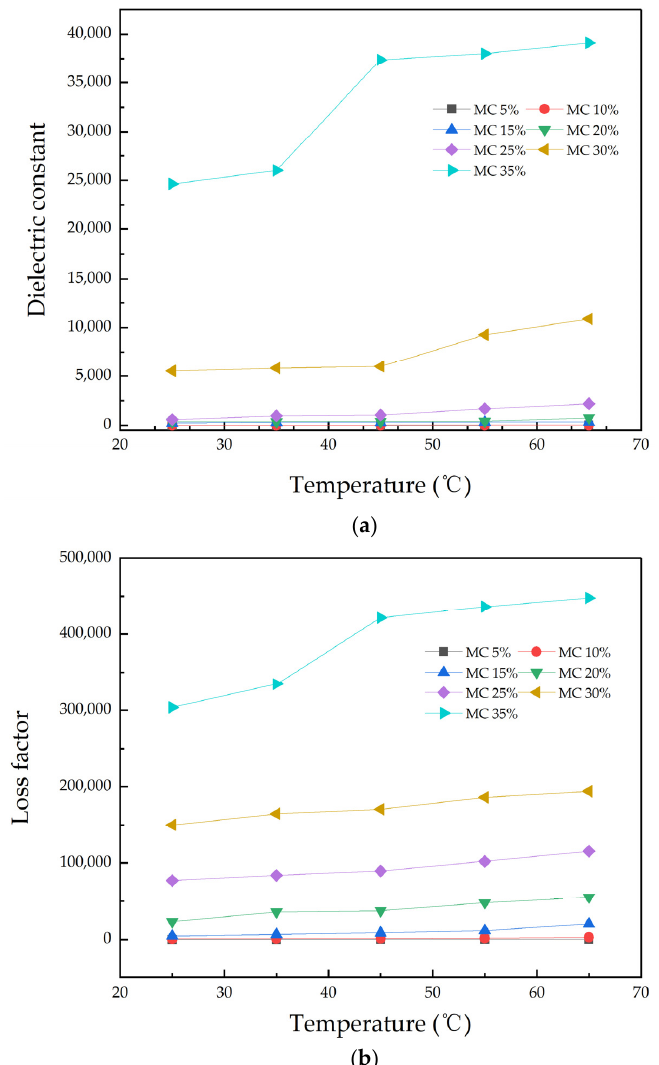
Figure 6. Temperature dependence of dielectric properties at various moisture contents: ( a ) dielectric constant, ( b ) loss factor.